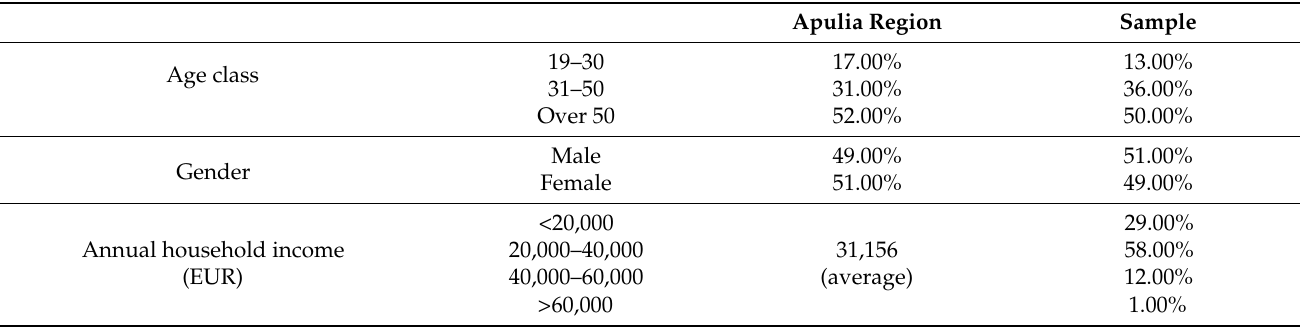
Table 3. Sampling of the respondents taking into consideration the age, gender, and household revenue of the population in the Apulia